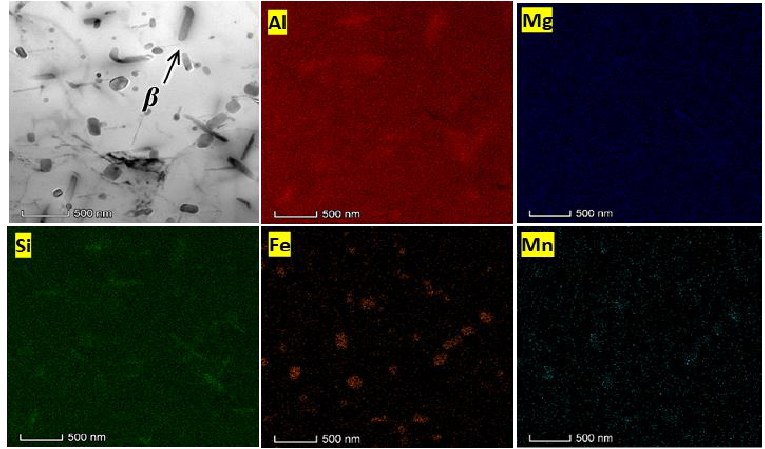
Figure 9. TEM precipitate morphology and element distribution maps at 400 °C.